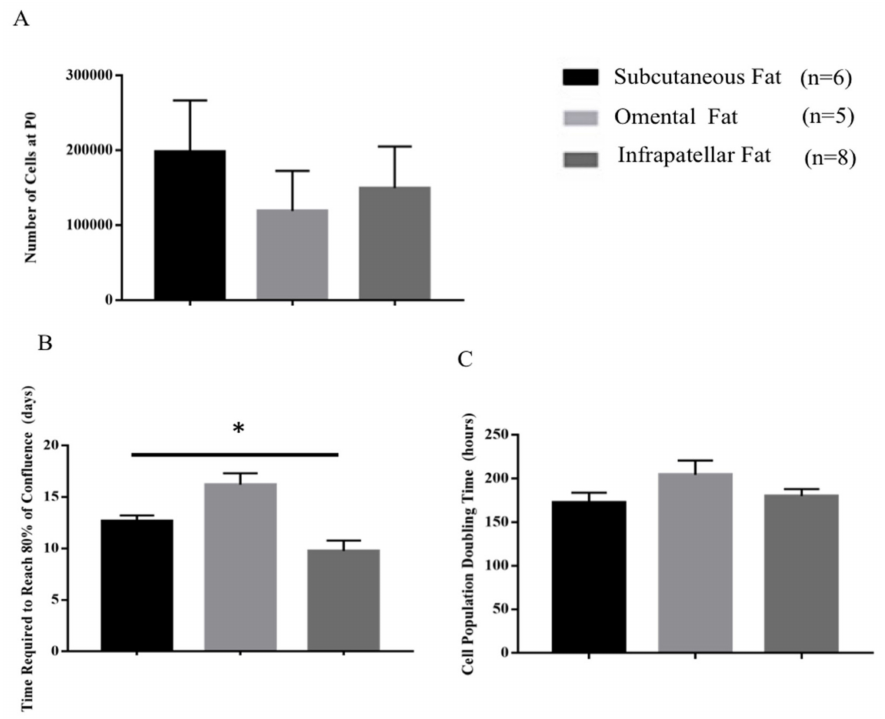
Figure 2. Cell yield at P0 ( A ), time required for ASCs reach to 80% confluency at P0 ( B ) and population doubling time ( C ). No significant differences were detected in cell yield and population doubling time among ASCs isolated from three of the fat sources. Isolated ASCs from infrapatellar fat required shorter time to reach 80% of confluency compared to two other sources. All graphs show mean measurements ± SEM. The results are representative of measurements from six (subcutaneous fat), five (omental fat) and eight (infrapatellar fat) biologically independent samples. * Represents statistically significant difference across three sources using one-way ANOVA ( p <